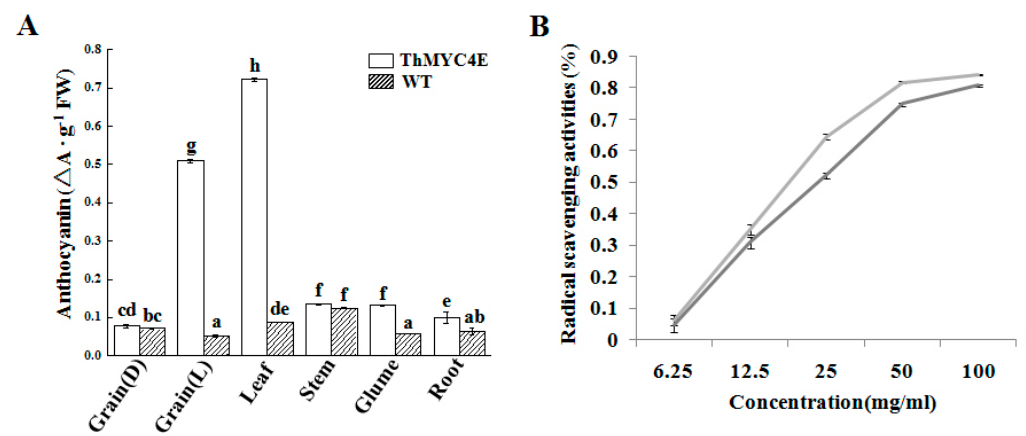
Figure 3. The anthocyanin content of different tissues and DPPH radical scavenging activities in the grains of transgenic lines and the WT. ( A ) The anthocyanin content in different tissues of transgenic lines and the WT. Vertical bars are error bars. Different letters in columns indicate statistically significant differences ( p < 0.01). ( B ) DPPH radical scavenging activities in the grains of transgenic liens and the WT. X axis represents the concentration of solution and the Y axis represents reducing power. The light gray line represents DPPH radical scavenging activities of transgenic wheat, deep gray line represents DPPH radical scavenging activities of the WT.